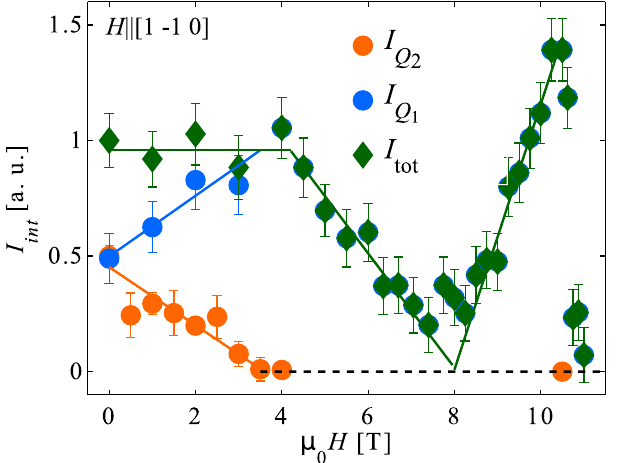
Figure 4. Field-induced Domain imbalance. Field dependence of the two magnetic domains, Q 1 and Q 2 , in Nd 0.05 Ce 0.95 CoIn 5 for H ||[1 1 0] and the total intensity I tot = I presented here and the ones reported in ref. 26 The Solid lines represent weighted linear